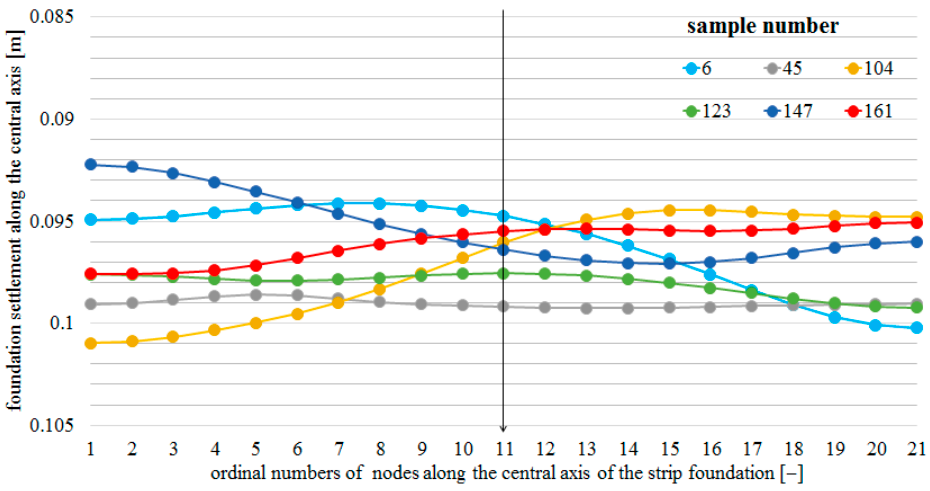
Figure 15. Convergence of simulation-based strip foundation settlement estimation, n E = 400. Figure 16 shows selected settlement cases along the foundation central axis.